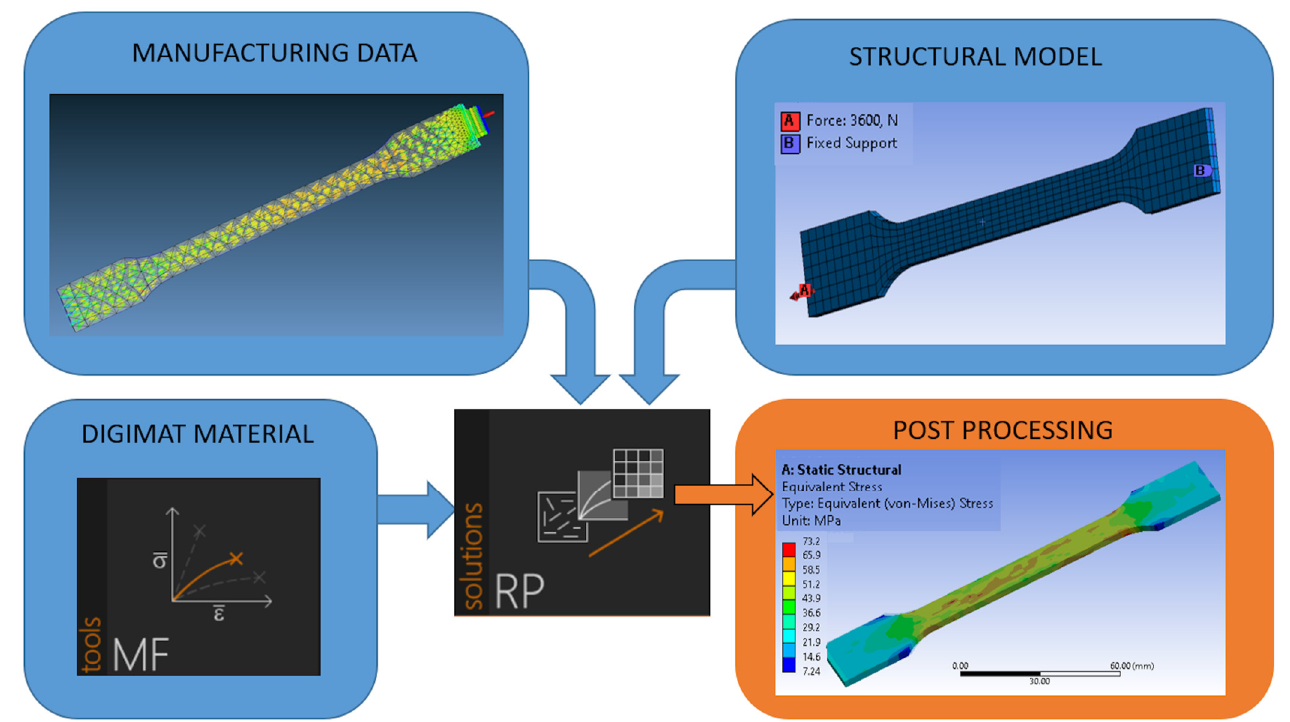
Figure 5. Computing flow chart.